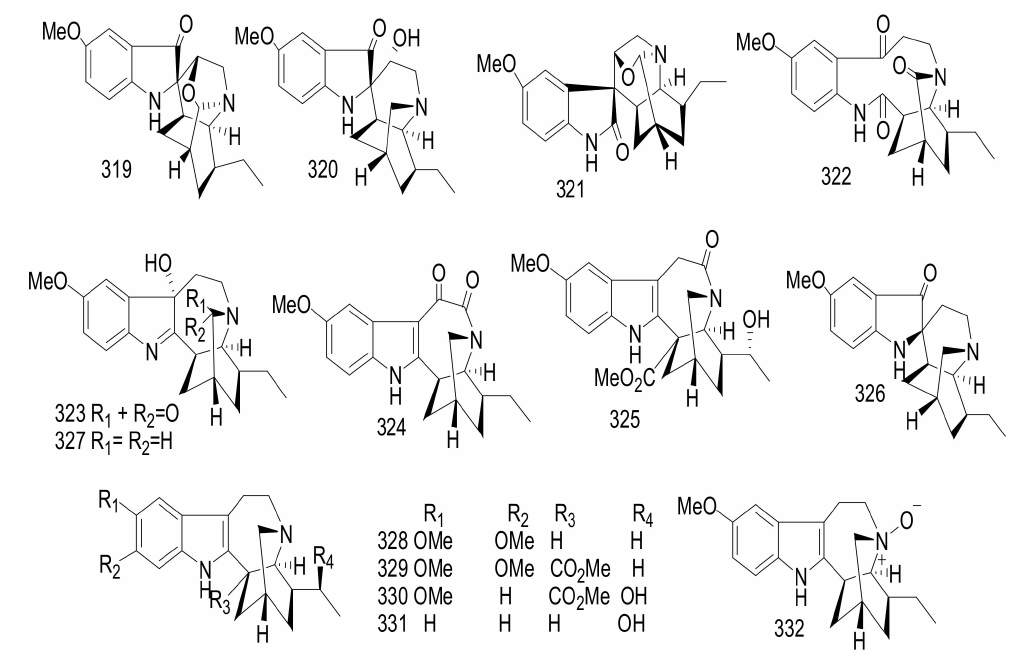
Figure 26. Compounds 319 – 332 .